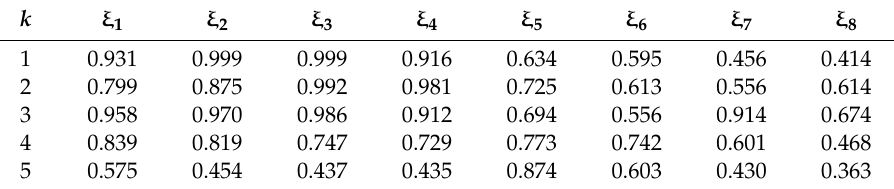
Table 7. Results of correlation coe ffi cient sequences.